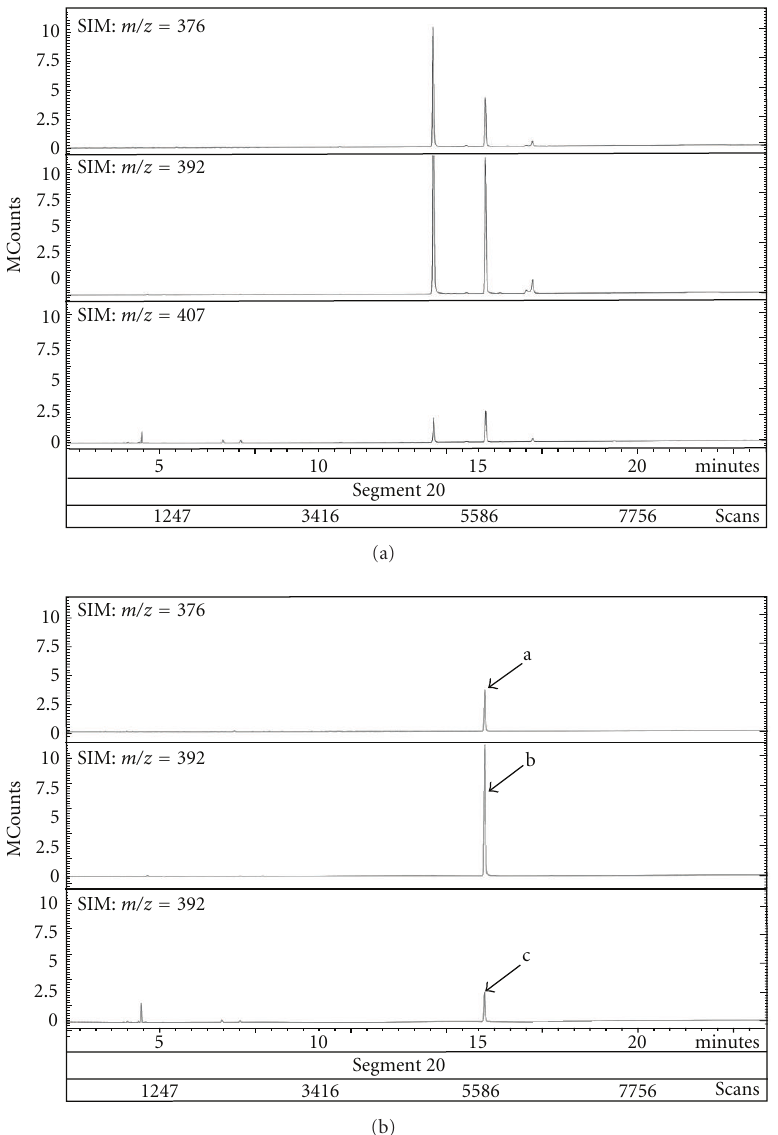
Figure 4: GC-MS analysis of TMS derivative of C9 base from TTX in D. cultripes . (a) Viscera. (b) TTX standards. ((a) m/z = 376; (b) m/z = 392; (c) m/z = 407)).